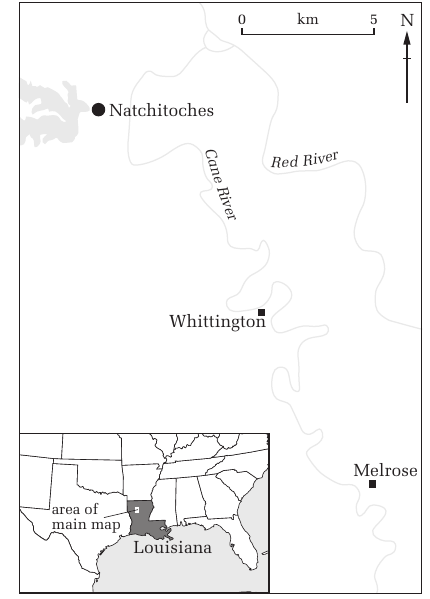
Figure 1 Western Louisiana, showing the location of Natchitoches and other sites mentioned in the